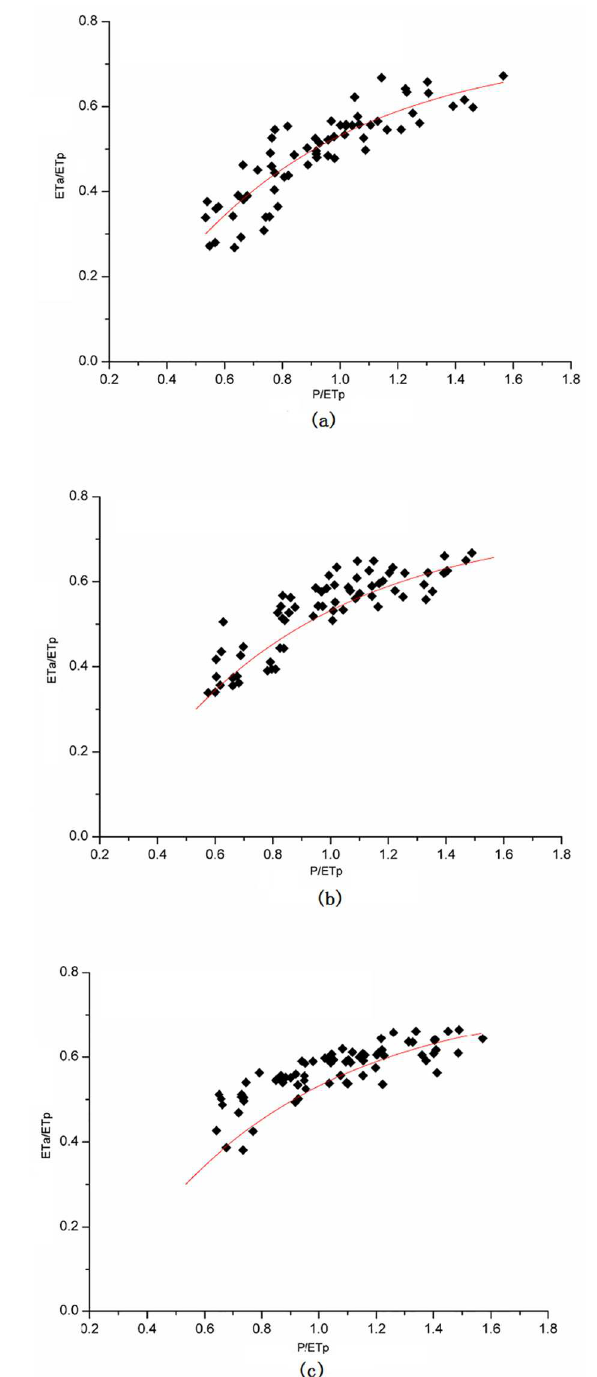
Fig 5. Relationship between evapotranspiration efficiency (ETa/ETp) and humidity (P/ETp) for different NDVI classifications: (a) NDVI (cid:20) 0.1; (b) 0.3 < NDVI (cid:20) 0.4; and (c) 0.7 < NDVI (cid:20)